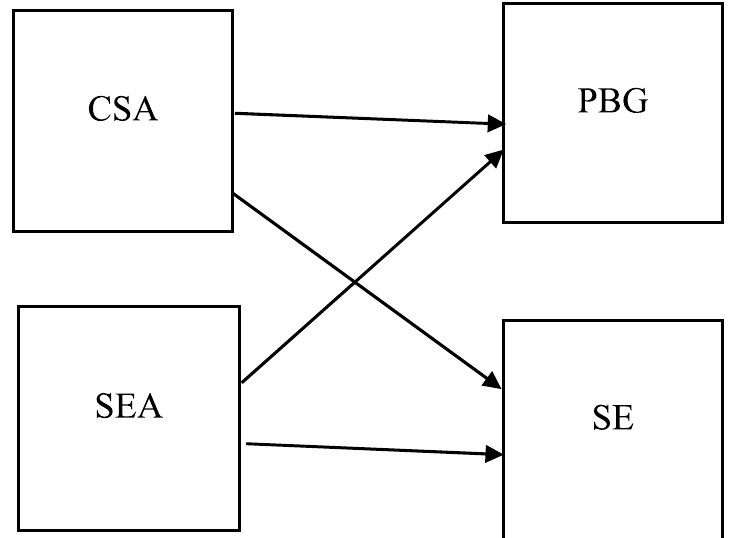
Fig. 1 Theoretical structural equation